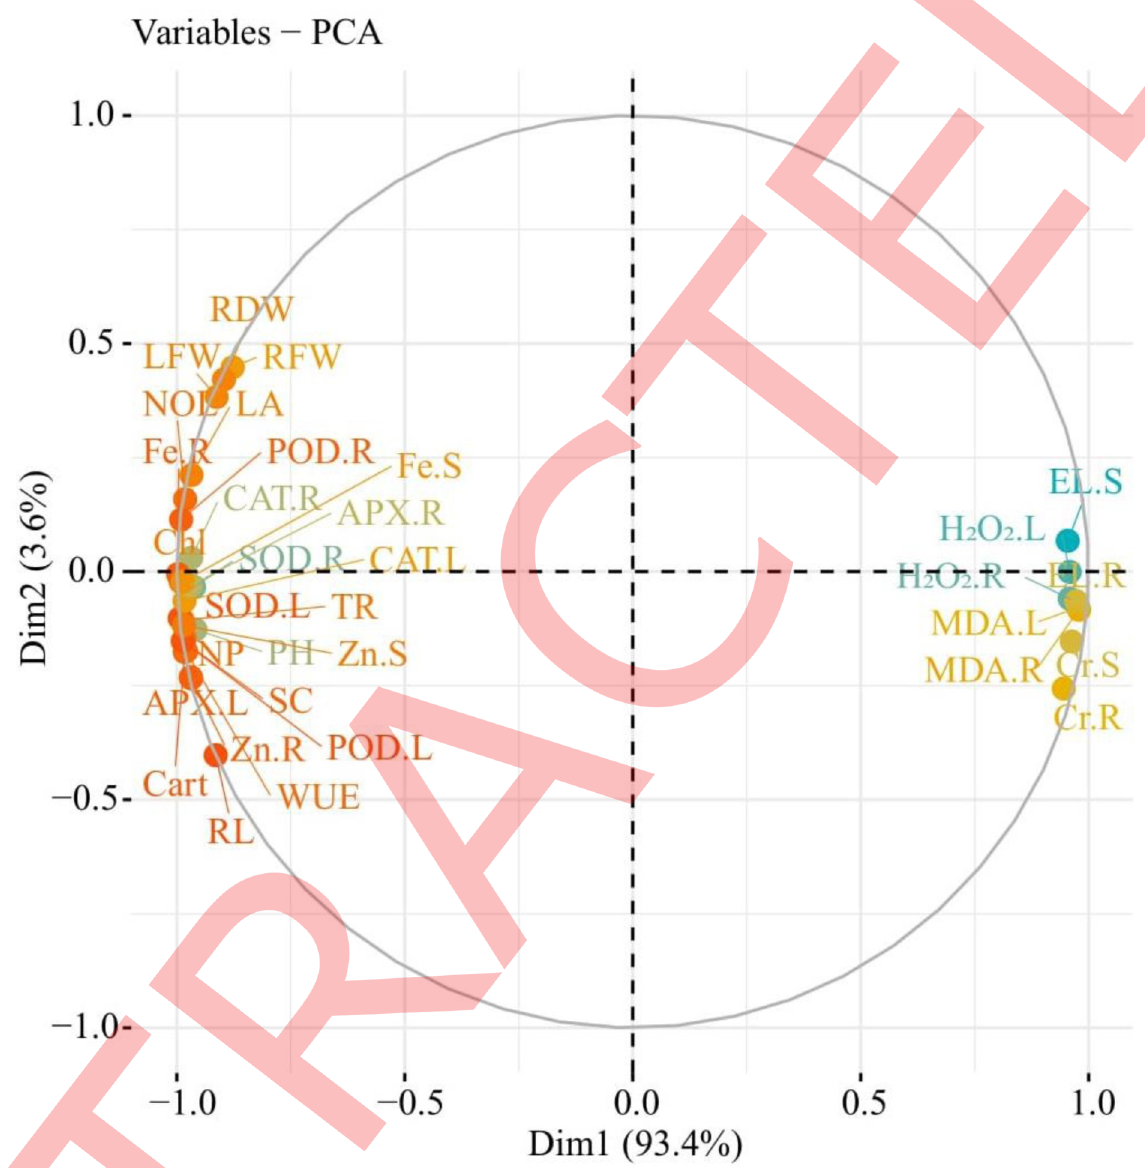
Fig 8. Loading plots of Principal Component Analysis (PCA) on different morpho-physiological traits, Zn and Fe contents with Cr uptake in different parts of B . napus . Different abbreviations used in this figure are as follow: LFW (leaves fresh weight), Fe-R (Fe contents in roots), MDA-R (MDA contents in roots), CR-R (Cr contents in roots), H 2 O 2 -R (H 2 O 2 initiation in roots), H 2 O 2 -L (H 2 O 2 initiation in leaves), MDA-L (MDA contents in leaves), EL-L (electrolyte leakage in leaves), EL-R (electrolyte leakage in roots), CR-S (Cr contents in leaves), RFW (root fresh weight), RDW (root dry weight), Fe-S (Fe contents in shoots), SOD-L (SOD activity in leaves), POD-L (POD activity in leaves), SOD-R (SOD activity in roots), Zn-R (Zn contents in roots), POD-R (POD activity in roots), Zn-S (Zn contents in shoots), LA (leaf area), Chl (total chlorophyll contents), PH (plant height), RL (root length), NP (net photosynthesis), CAT-R (CAT activity in roots), CAT-L (CAT activity in leaves), APX-R (APX activity in roots), TR (transpiration rate), SC (stomatal conductance), WUE (water use efficiency), NOL (number of leaves), Carot (carotenoid contents), APX-L (APX activity in leaves).